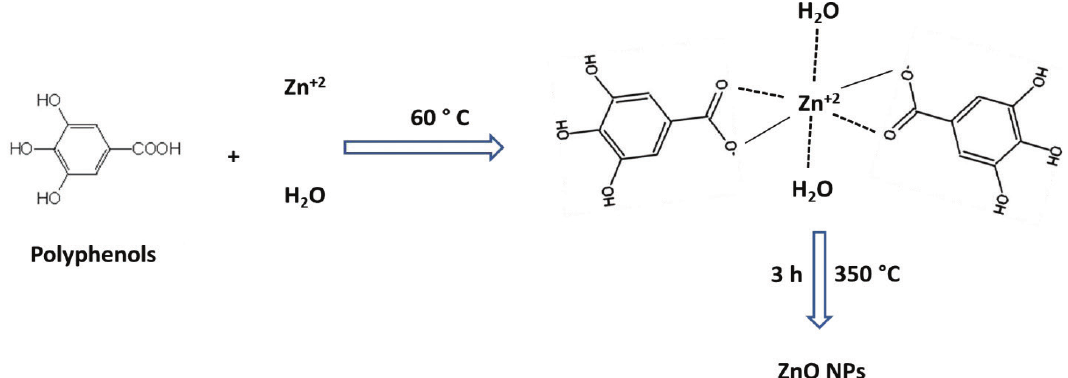
Figure 6: Plausible mechanism of ZnO NPs using Punica granatum